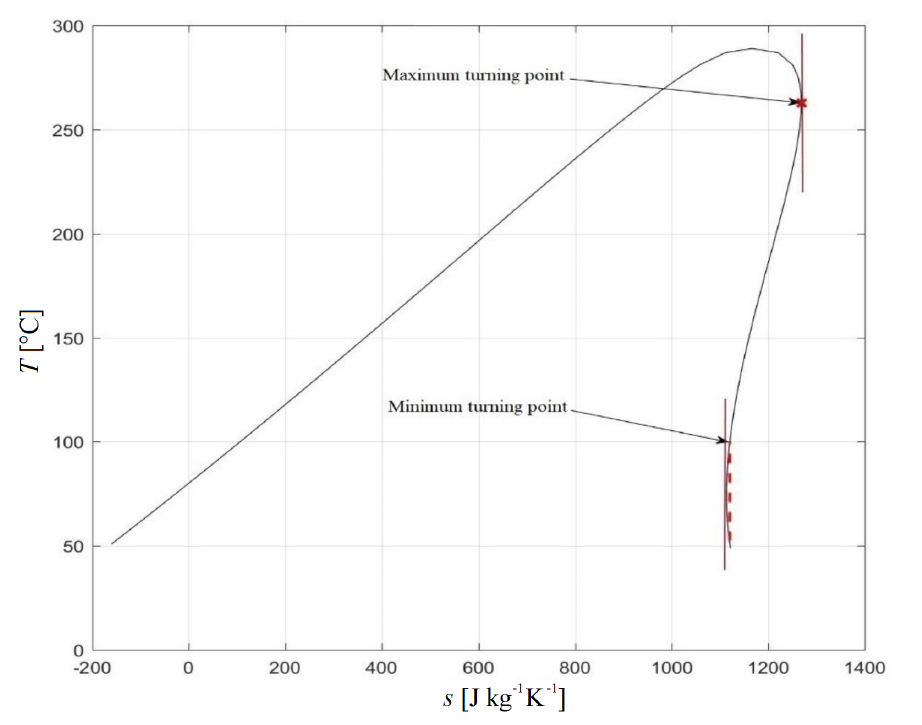
Figure 4. Turning points for the